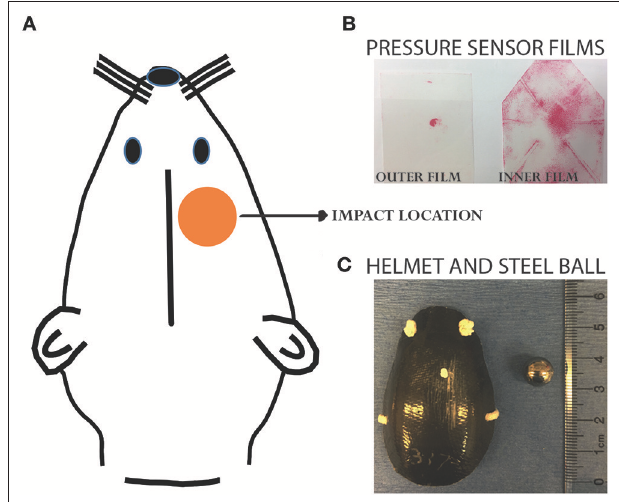
FIGURE 1 | Projectile concussive injury model. (A) Illustration showing the impact location on a rat head. (B) Pressure sensor films following an impact. (C) Helmet and steel ball used for the impact. Please refer to our previous publications for more details of the PCI device ( 9,